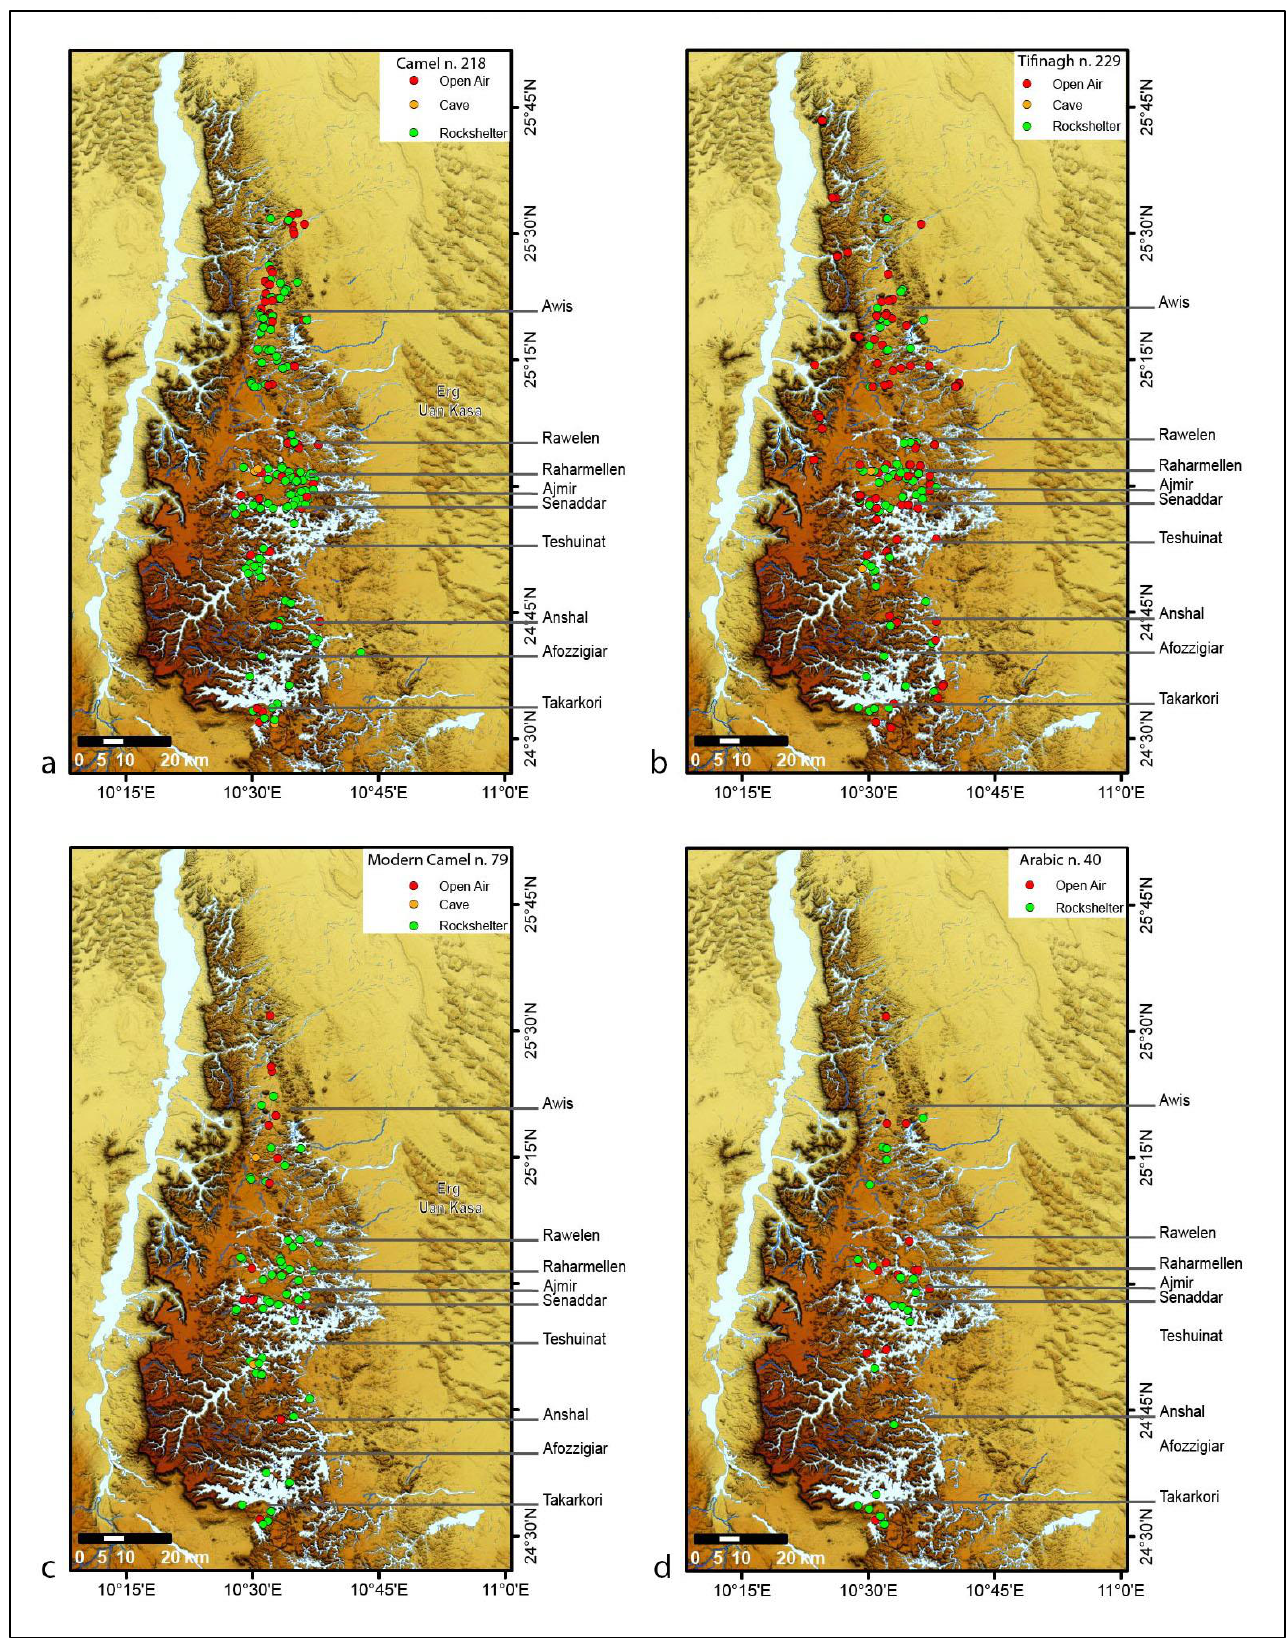
Figure 14. Distributions of stylistic testimonies: (a) Camel, (b) Tifinagh, (c) Modern Camel, (d) Islamic. Site dots are distinguished by type: Open Air, Cave,